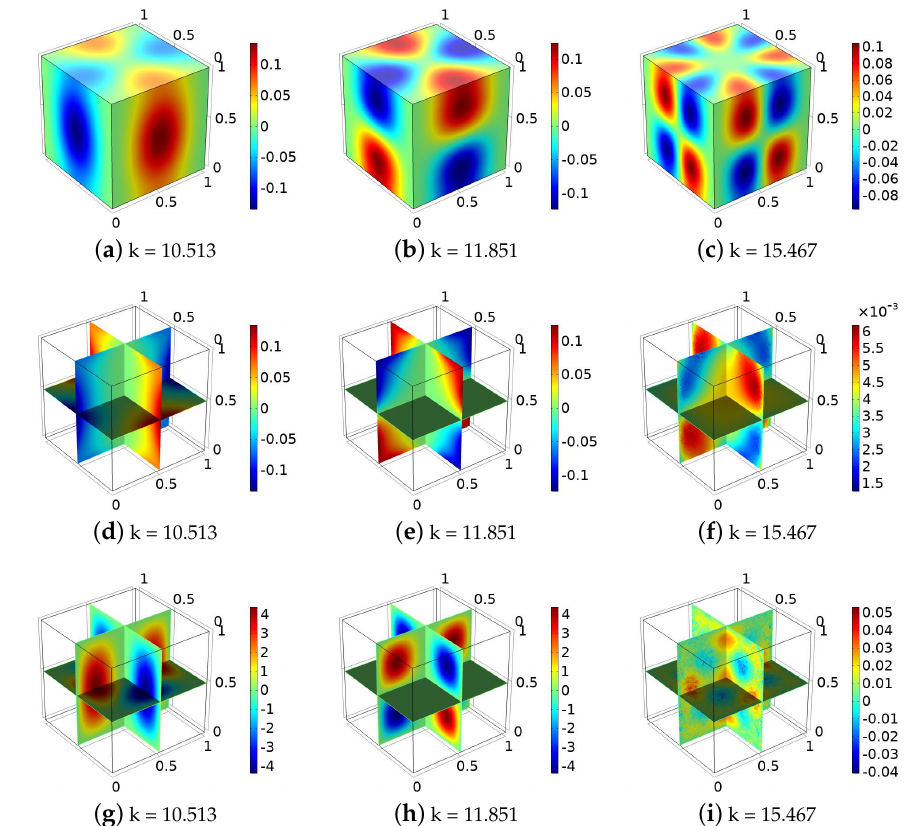
Figure 7. The magnitude of transmission eigenfunctions for a cube with different k ’s. ( a – c ): surface of w ’s and v ’s; ( d – f ): eigenfunctions w ’s; and ( g – i ): eigenfunctions v